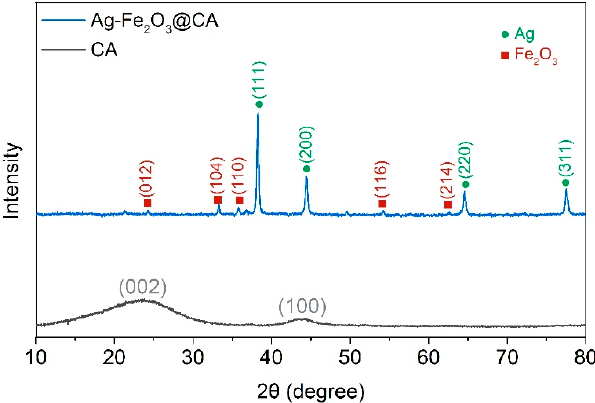
Figure 4. XRD pattern of carbon aerogel (CA) and Ag–Fe 2 O 3 @CA. Polymers 2018 , 10 , 193